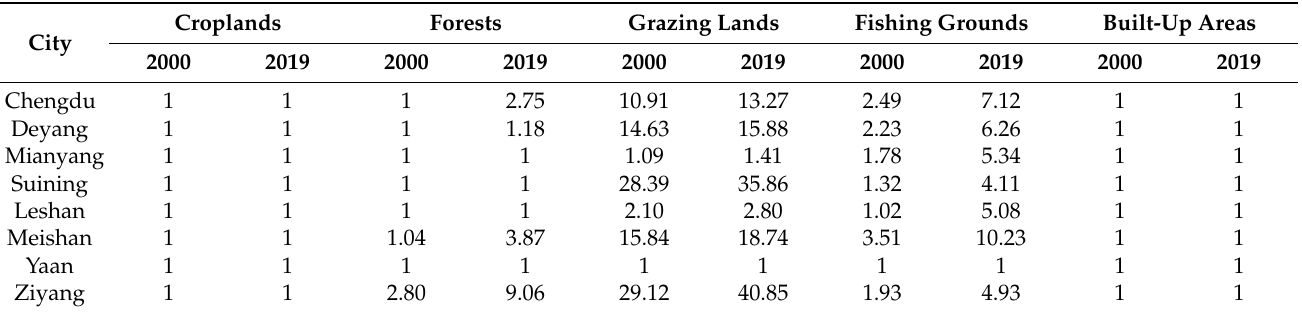
Table 4. EF depth of land types. Table 5. Per capita 3D ecological footprint from 2000 to 2019 (hm 2 ).